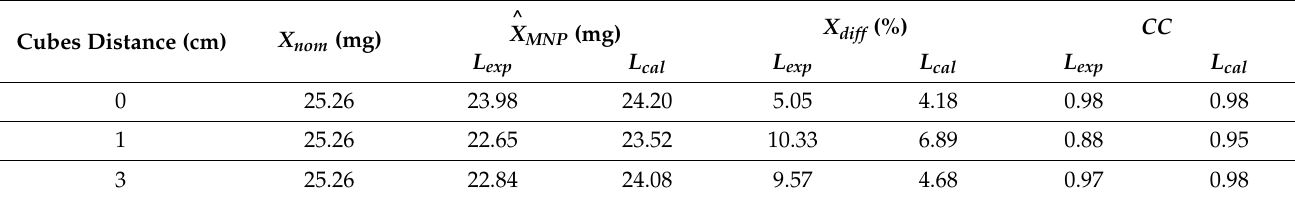
Figure 6. Nominal and reconstructed MNPs’ distributions with two MNP loaded cubes located in the FOV at the same time. The first row is the nominal distributions; the second row shows the reconstructions using L exp ; and the third row shows reconstructions using L cal . The columns indicate the distance between both cubes, e.g., for cube E1 and E2 with the face-to-face distance of 0, 1, and 3 cm. Table 2. CC and X dif f estimated for the ACB reconstructions of two MNP loaded cubes for different distances separating those cubes in the FOV.